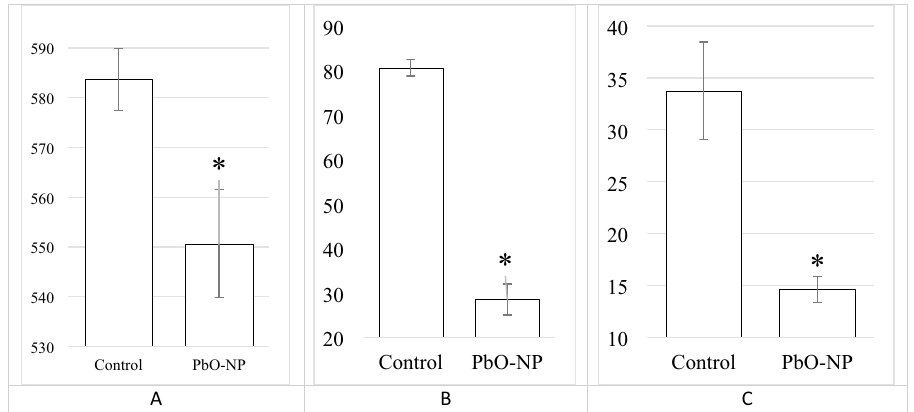
Figure 8. Changes in the activity of succinate dehydrogenase in rat blood lymphocytes ( A ), the concentration of reduced glutathione in blood hemolysate ( B ) and ceruloplasmin in blood serum ( C ) under effect of PbO NPs. The magnitude of the effect is marked on the y axis. Note *Statistically different from the control group ( p <